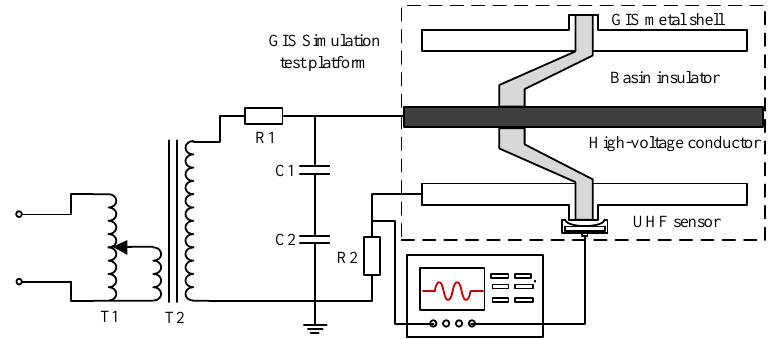
Figure 5. Schematic diagram of the simulation test platform.